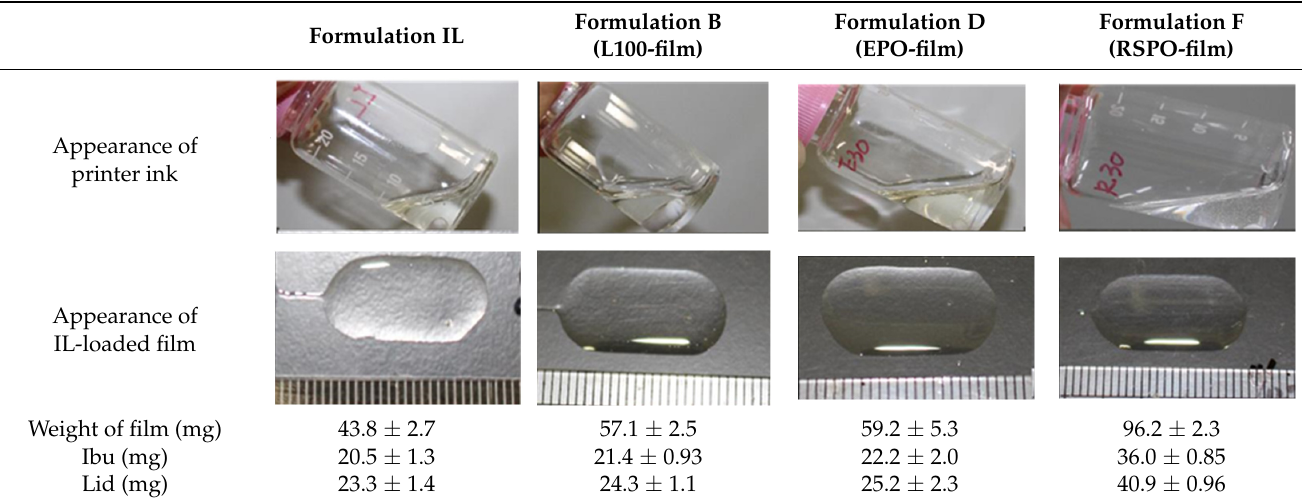
Table 2. Appearance of printer ink formulations and IL-loaded films after 3D printing and drying. The weights of the resulting films and estimated weight of Ibu and Lid in the films are shown. Information on the printer inks is shown in Table 1. These data represent the means ± standard deviations ( n = 3).